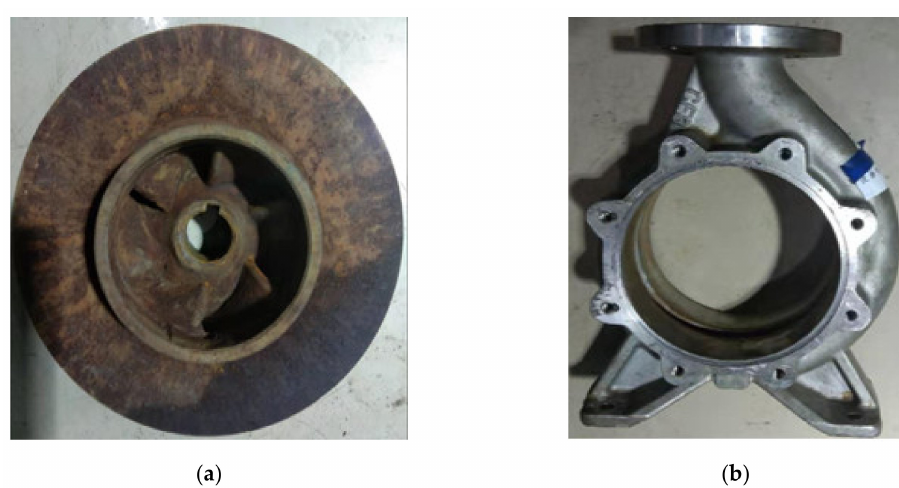
Figure 2. Pump-as-turbine (PAT) model: ( a ) impeller, ( b )